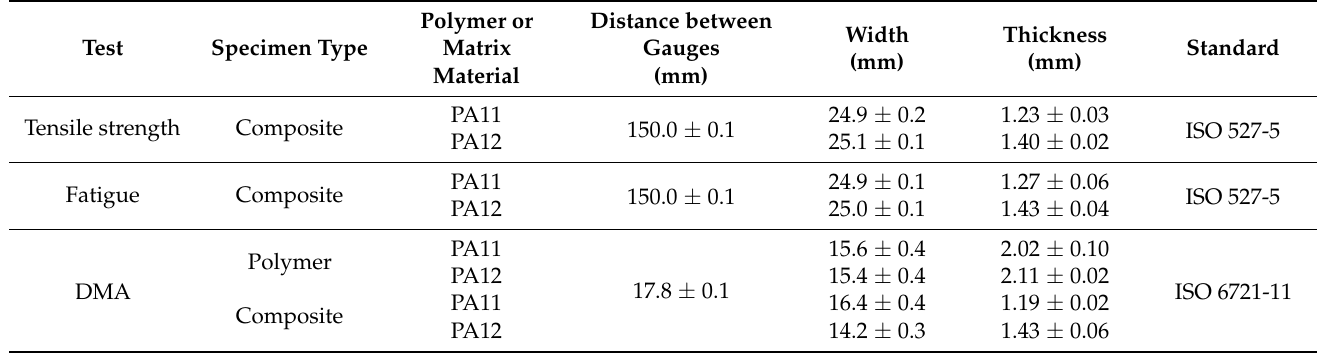
Table 3. Tests carried out, specimen dimensions, and standards used for